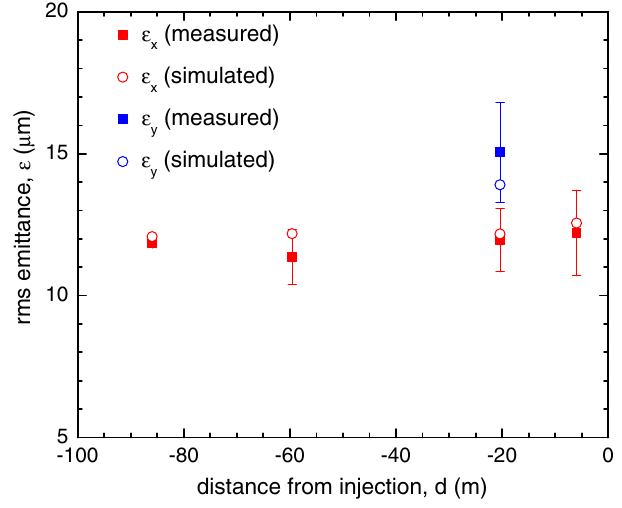
FIG. 15. Emittance evolution along the final stretch of the M5 line. Note that d ¼ 0 denotes the entrance of the storage ring of the Muon g − 2 experiment. Notice that the emittance is con- served in the horizontal plane and that it agrees well with the baseline design